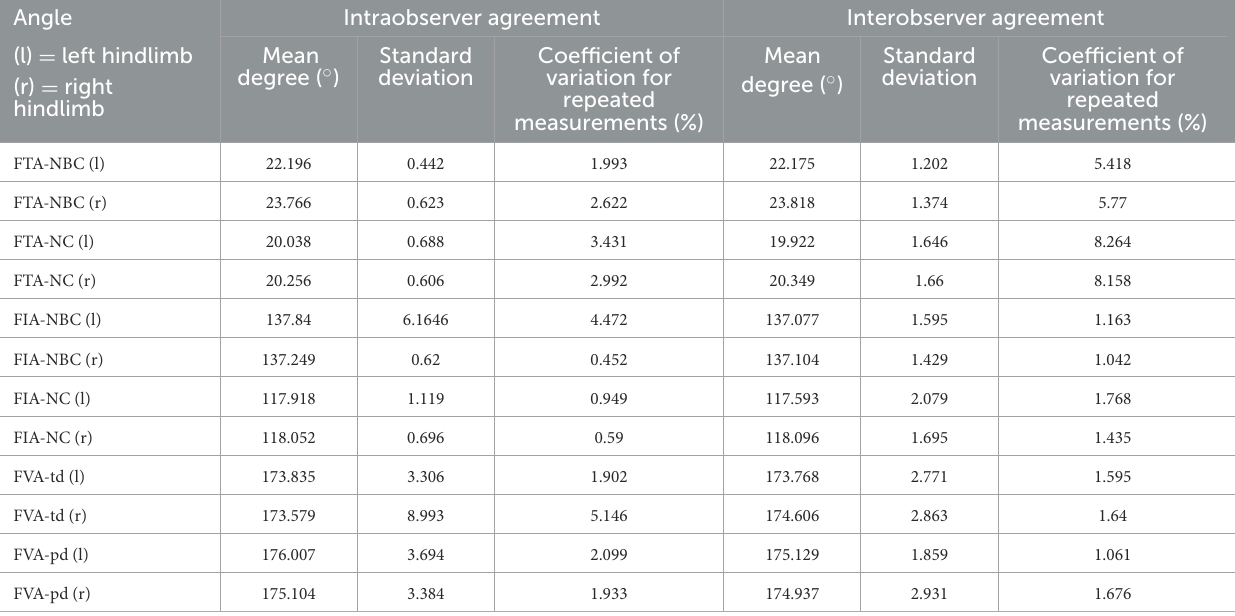
TABLE 2 Intra- and interobserver agreement of CT-based femoral angular measurements in a clinical setting in 34 dogs with a clinical diagnosis of patellar luxation that underwent preoperative CT examinations of both hind limbs for routine preoperative assessment and planning of surgical correction. Angle Intraobserver agreement Interobserver agreement